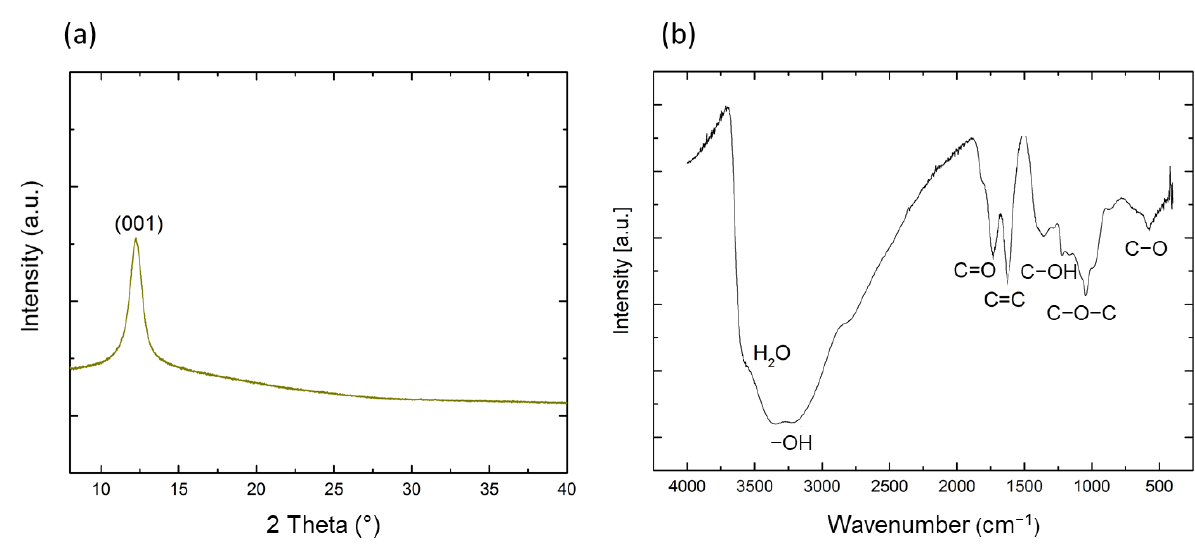
Figure 5. ( a ) XRD pattern and ( b ) FTIR spectra of the prepared GO.